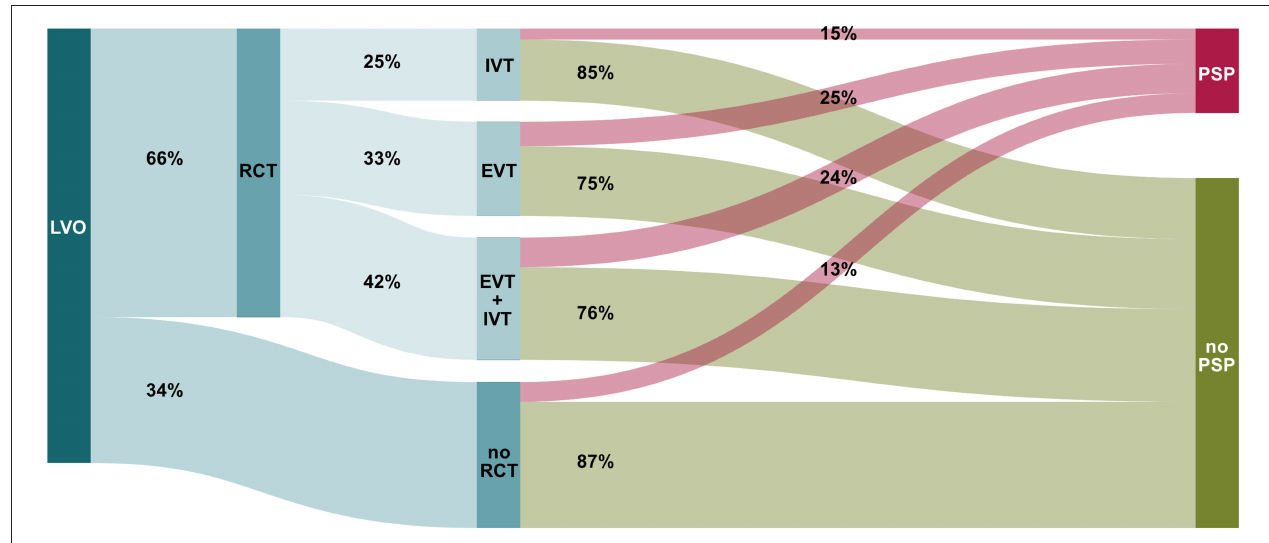
FIGURE 1 | Sankey diagram illustrating the share of patients who do or do not develop poststroke pneumonia (PSP) in acute ischemic stroke (AIS) due to large vessel occlusion (LVO) of the anterior circulation, depending on the respective recanalizing therapy (RCT, recanalization therapy; IVT, intra-venous thrombolysis; EVT, endovascular